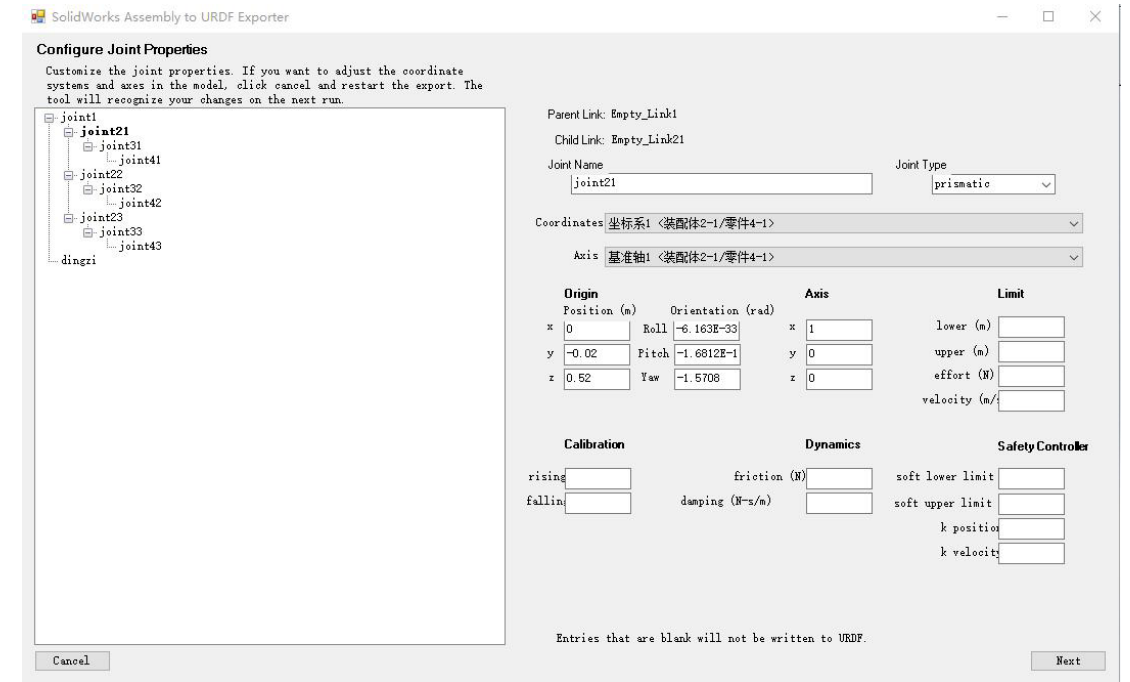
Figure 11. Joint configuration diagram.